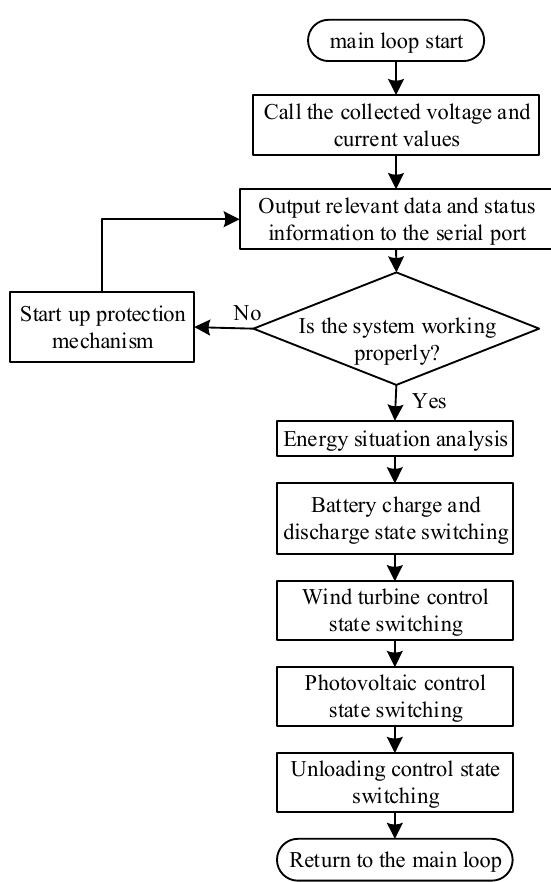
Figure 15. Main program flow chart.